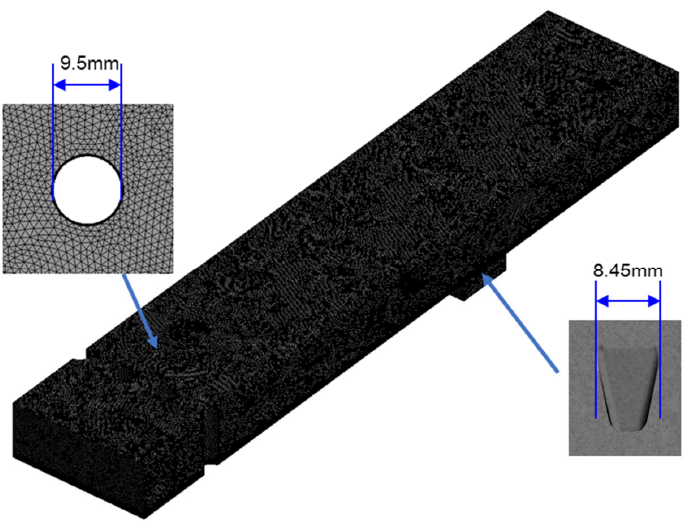
Figure 5. Computational meshes for the three ‐ dimensional CFD domain including a row of circular cylinders and fan ‐ shaped film cooling